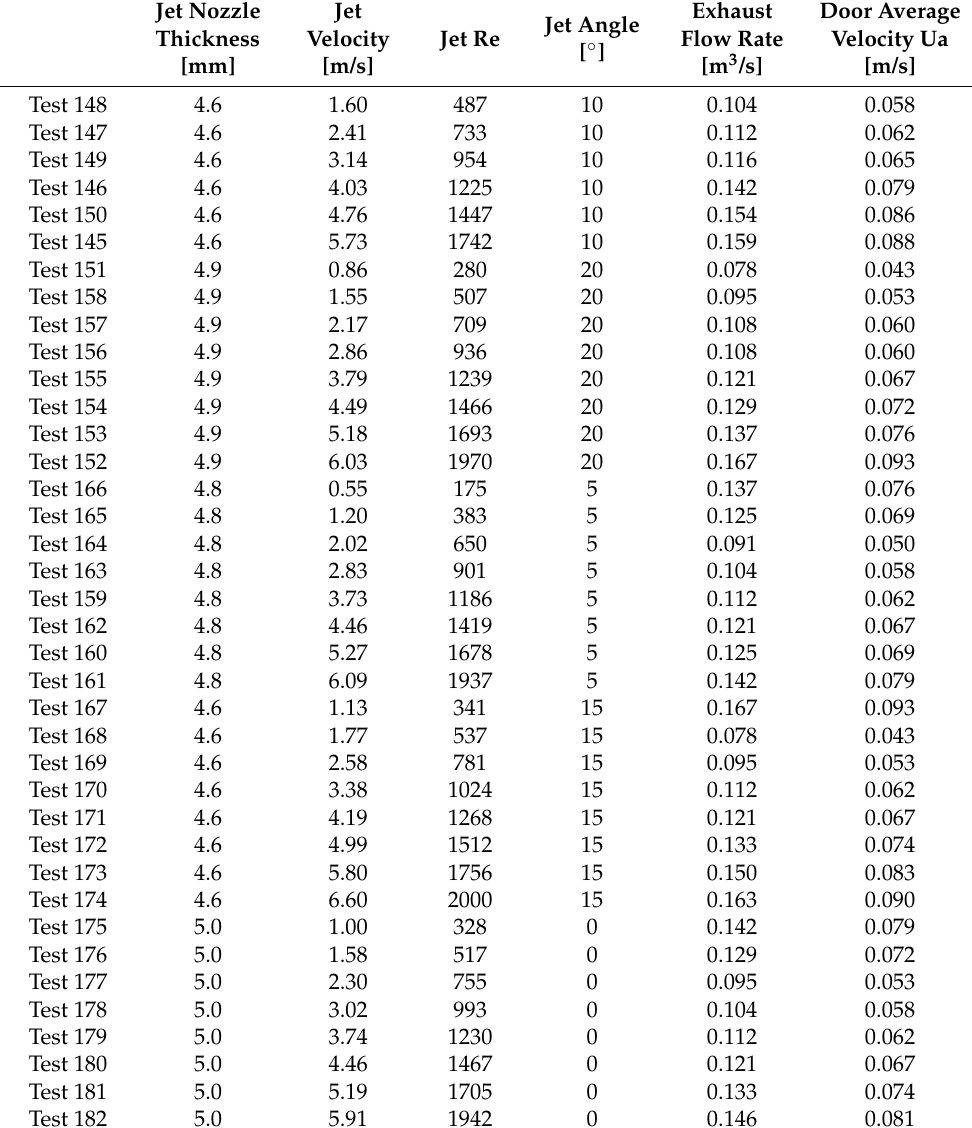
Table 1. Conditions of the tests for the 5 mm nominal thickness of the jet